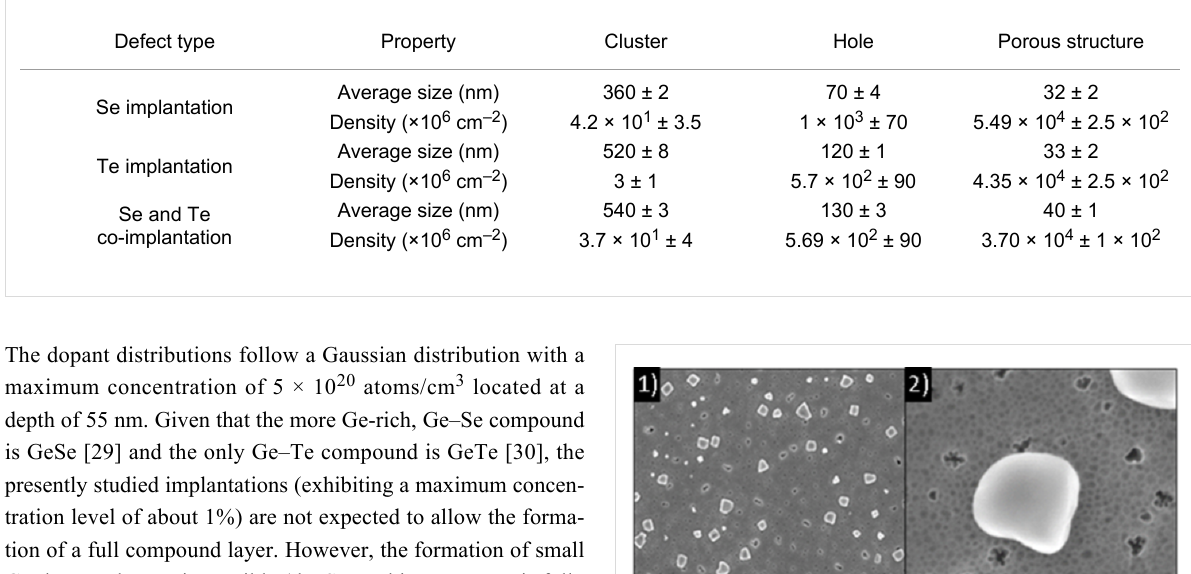
Table 1: Surface density and average lateral size of the different implantation-induced defects versus implanted species.